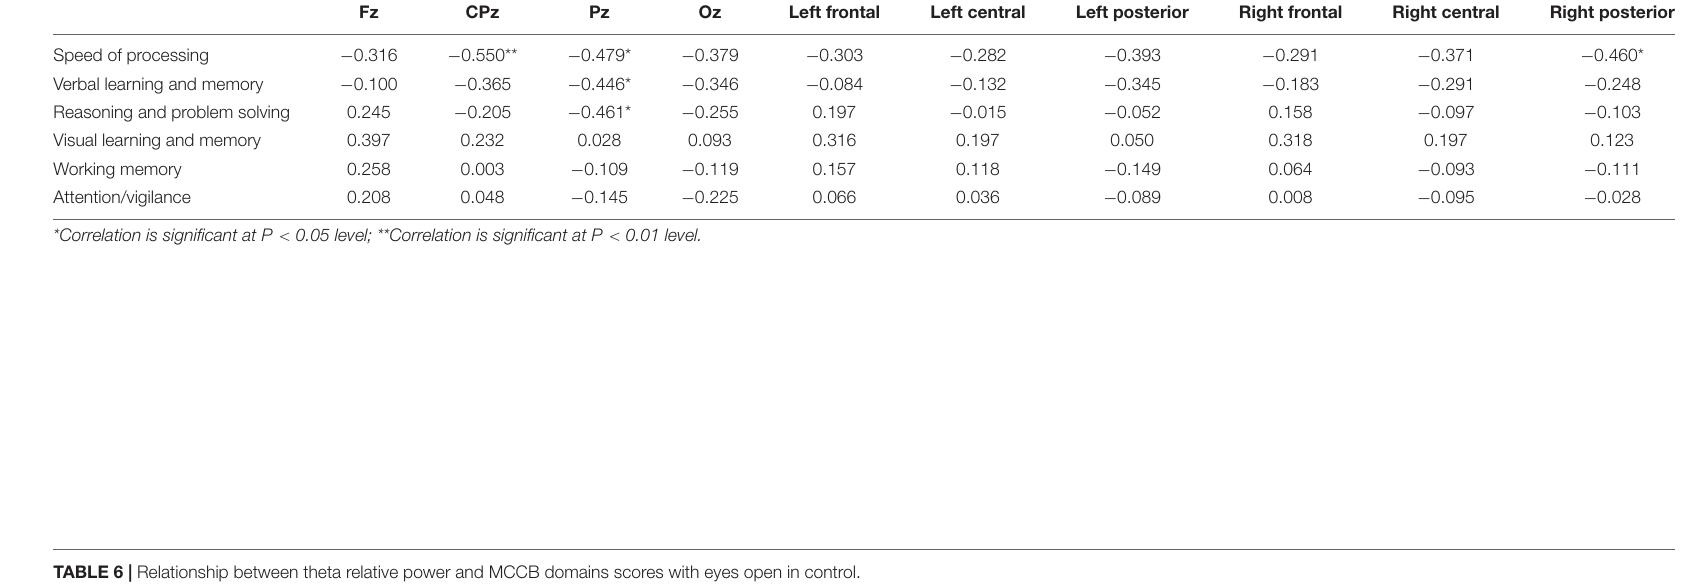
TABLE 6 | Relationship between theta relative power and MCCB domains scores with eyes open in control. Cognitive